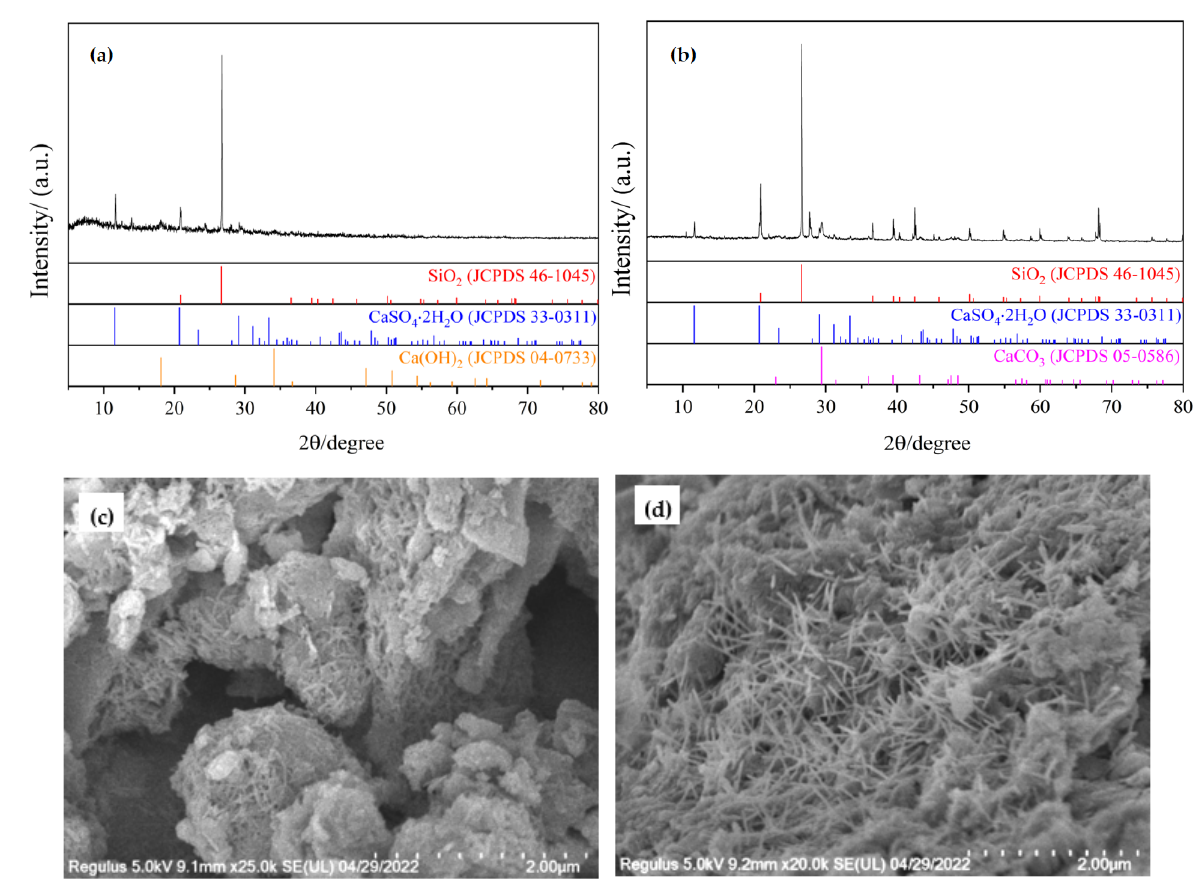
Figure 10. Comparison of the products and structures in the uncarbonized and carbonized parts of specimen III-A-2. ( a ) XRD of the uncarbonized part; ( b ) XRD of the carbonized part; ( c ) SEM of the uncarbonized part; ( d ) SEM of the carbonized part.